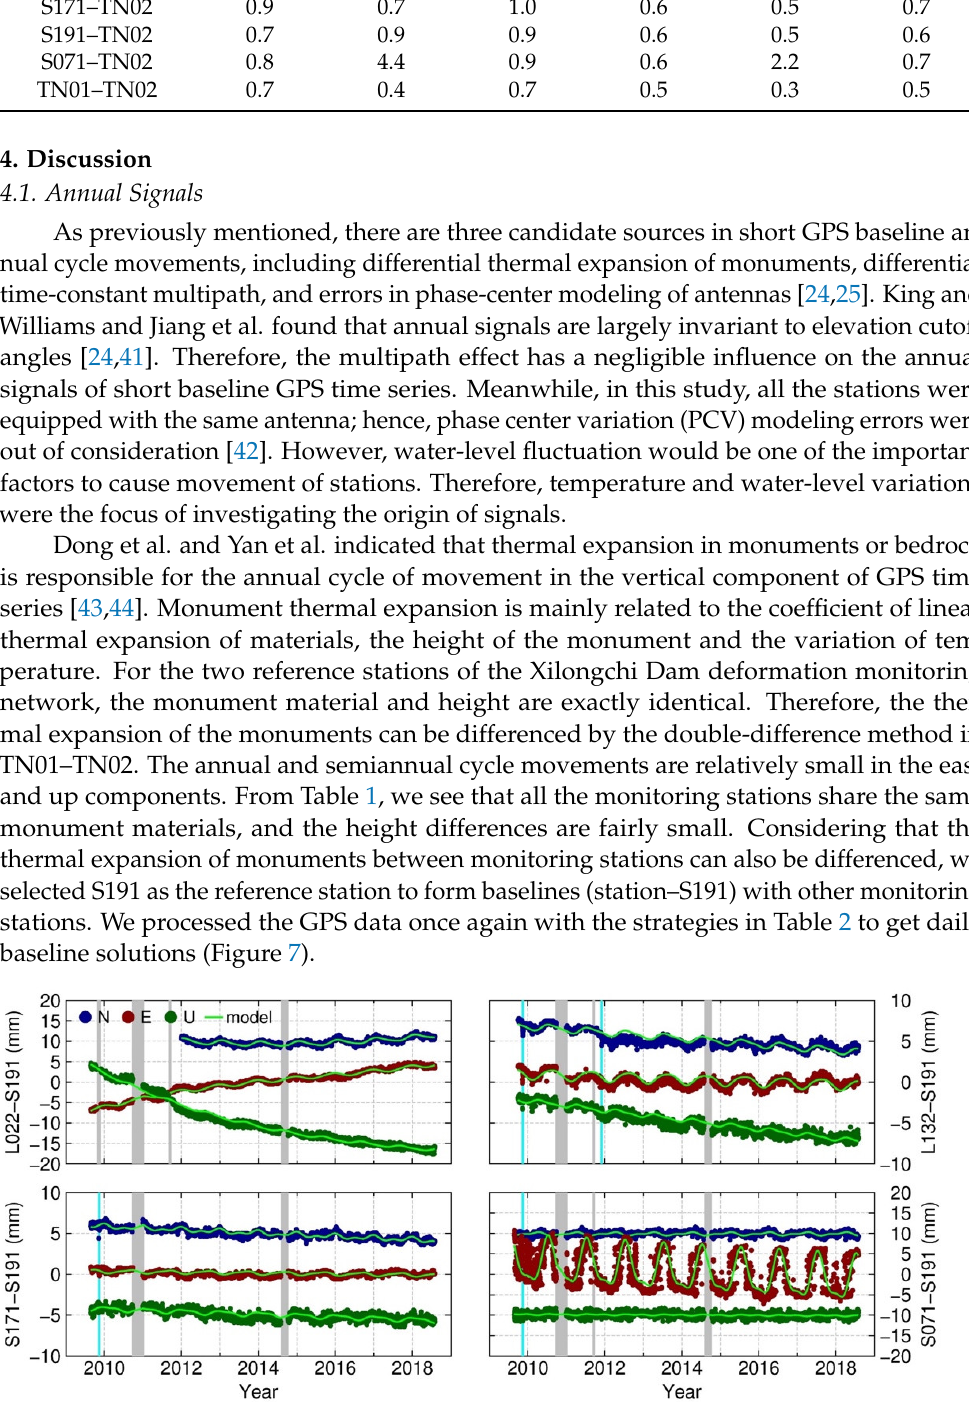
Figure 7. Baseline coordinate time series and their fitting models. The symbols and ranges of coordinates axes in the figure are same as those in Figure 4. In the north component of L022–S191, the time series were estimated starting from 2012.